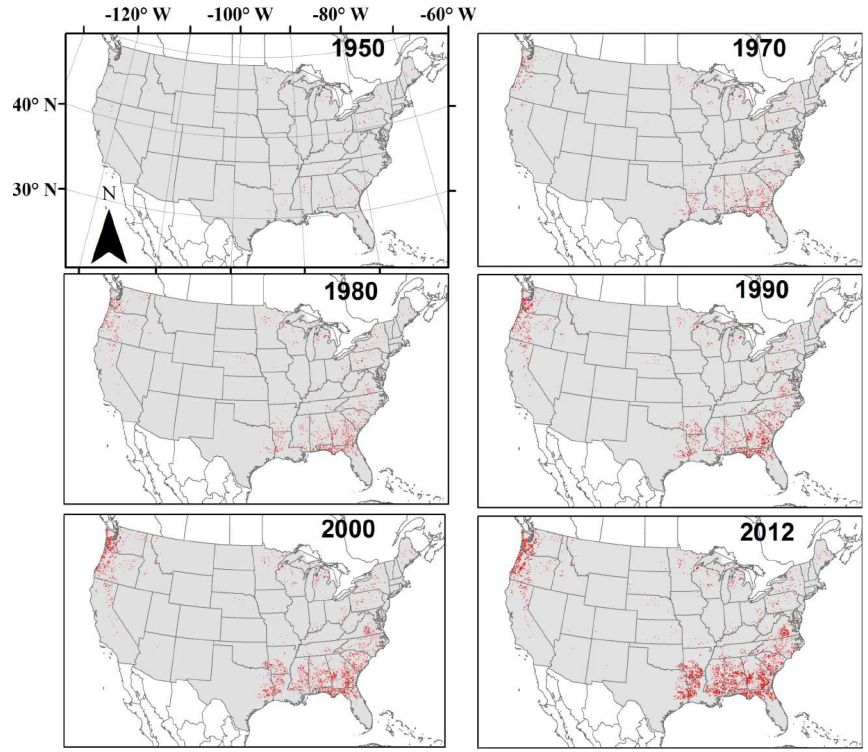
Figure 9. Spatial distributions for plantation forests during 1950, 1970, 1980, 1990, 2000, and 2012 at a spatial resolution of 8km for the